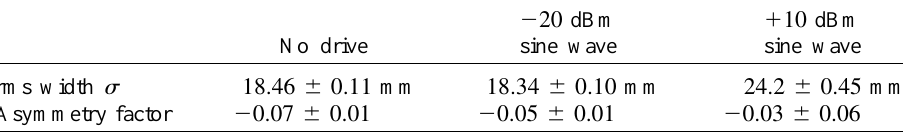
TABLE IV. The electron bunch length and asymmetry factor when the rf phase was modu- lated at a frequency of 369.9 kHz. The error bars for the data are the root mean error of the measurement. The bunch length with no drive and asymmetry value is used in fitting the data to determine the pulse-to-pulse residual and mean residual from the fit to the data.